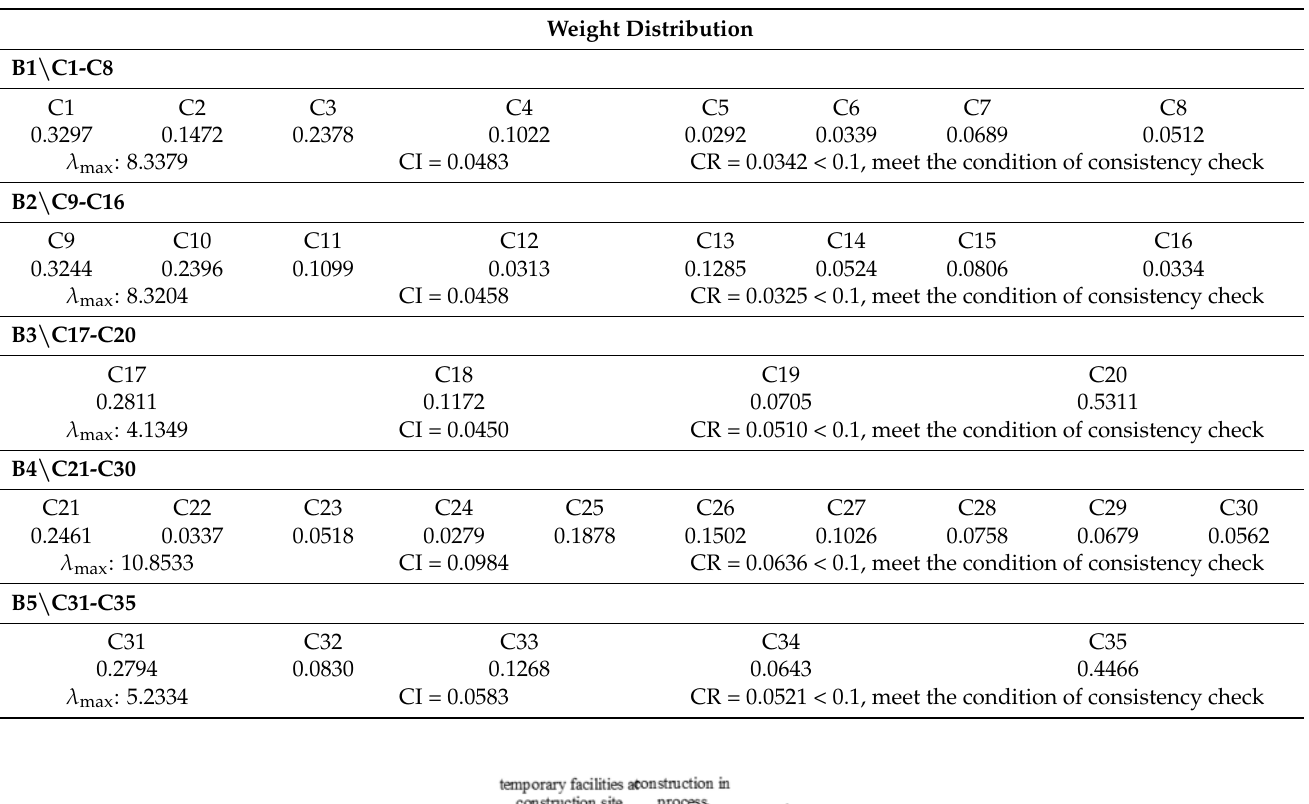
Table 8. The weight distribution for B and C.